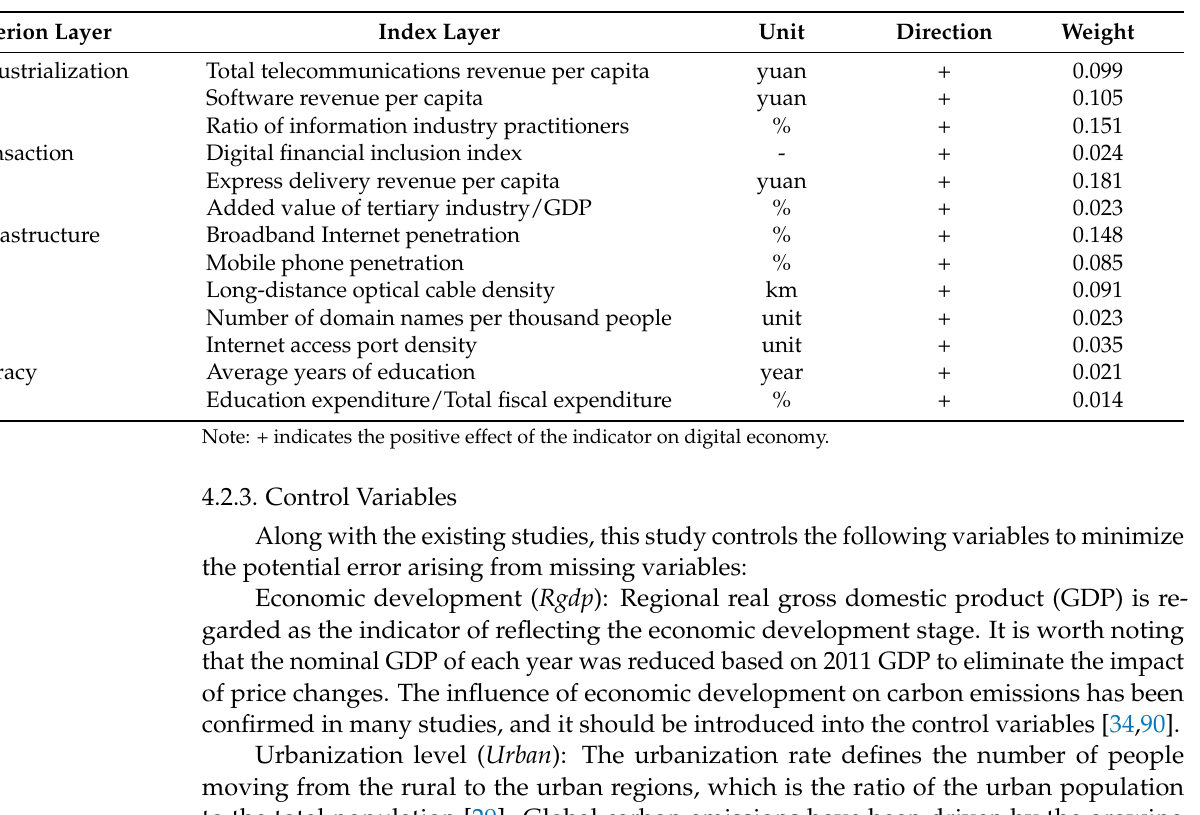
Table 3. The indicator system of measuring the digital